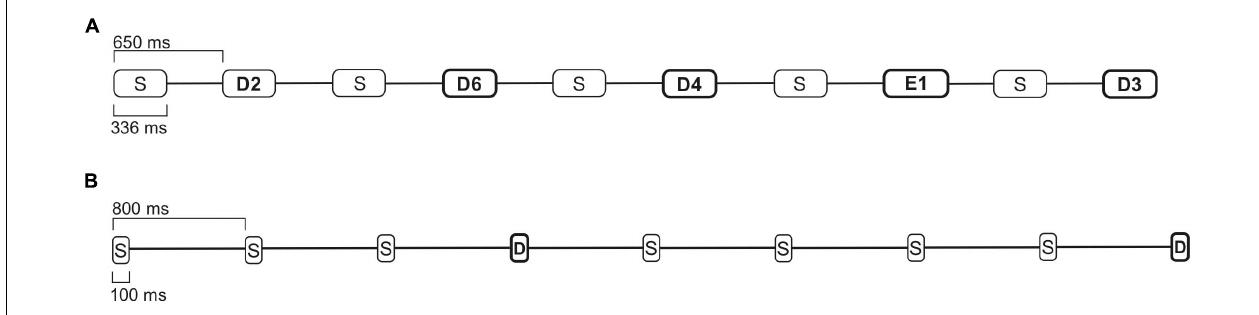
FIGURE 2 | The paradigm examples of 7 s intervals. (A) Multi-feature paradigm with standard (S), phonetic deviant (D), and emotional stimuli (E), with a 650 ms SOA. (B) A one-deviant oddball paradigm with standard (S) and deviant stimuli (D), with an 800 ms SOA.